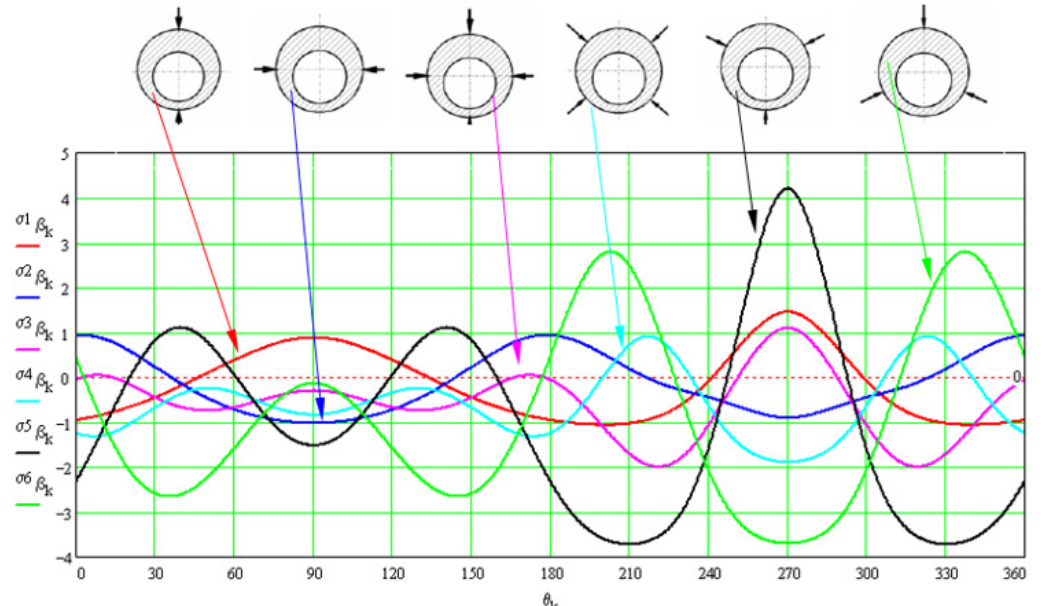
Figure 26. The hoop stress variation around the hole for the eccentric ring.